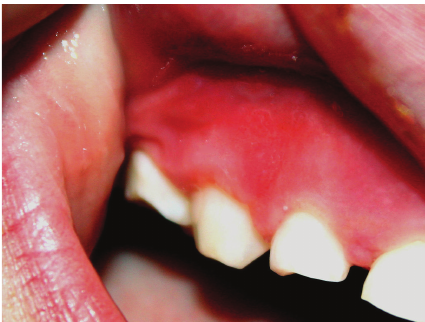
Figure 1: Mild mucosal erythema of the right anterior maxillary gingiva.